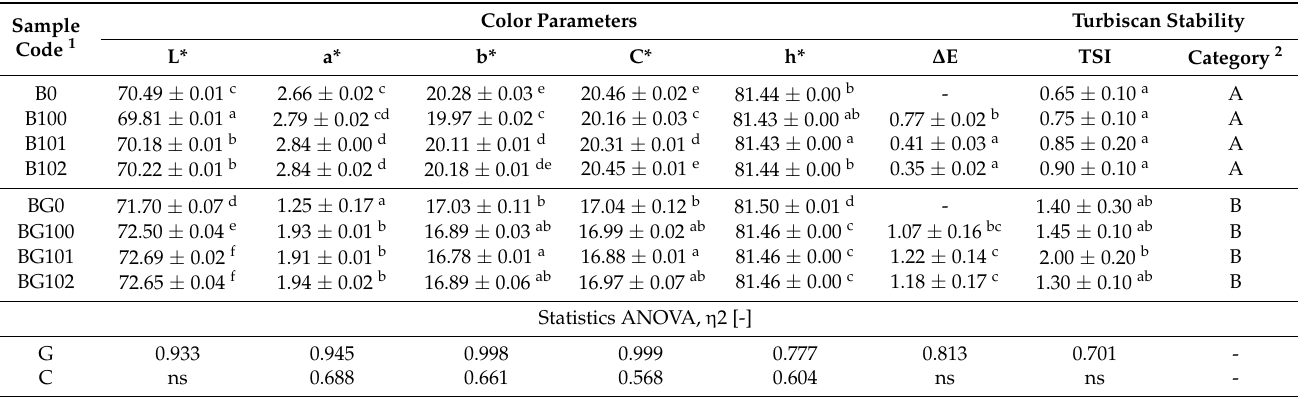
Table 3. Variations of color parameters L*, a*, b*, C*, h* and color difference ( ∆ E) between BBB before fermentation and after fermentation, and the results of Turbiscan Stability Index (TSI) after 21 days of storage at 6 ◦ C.